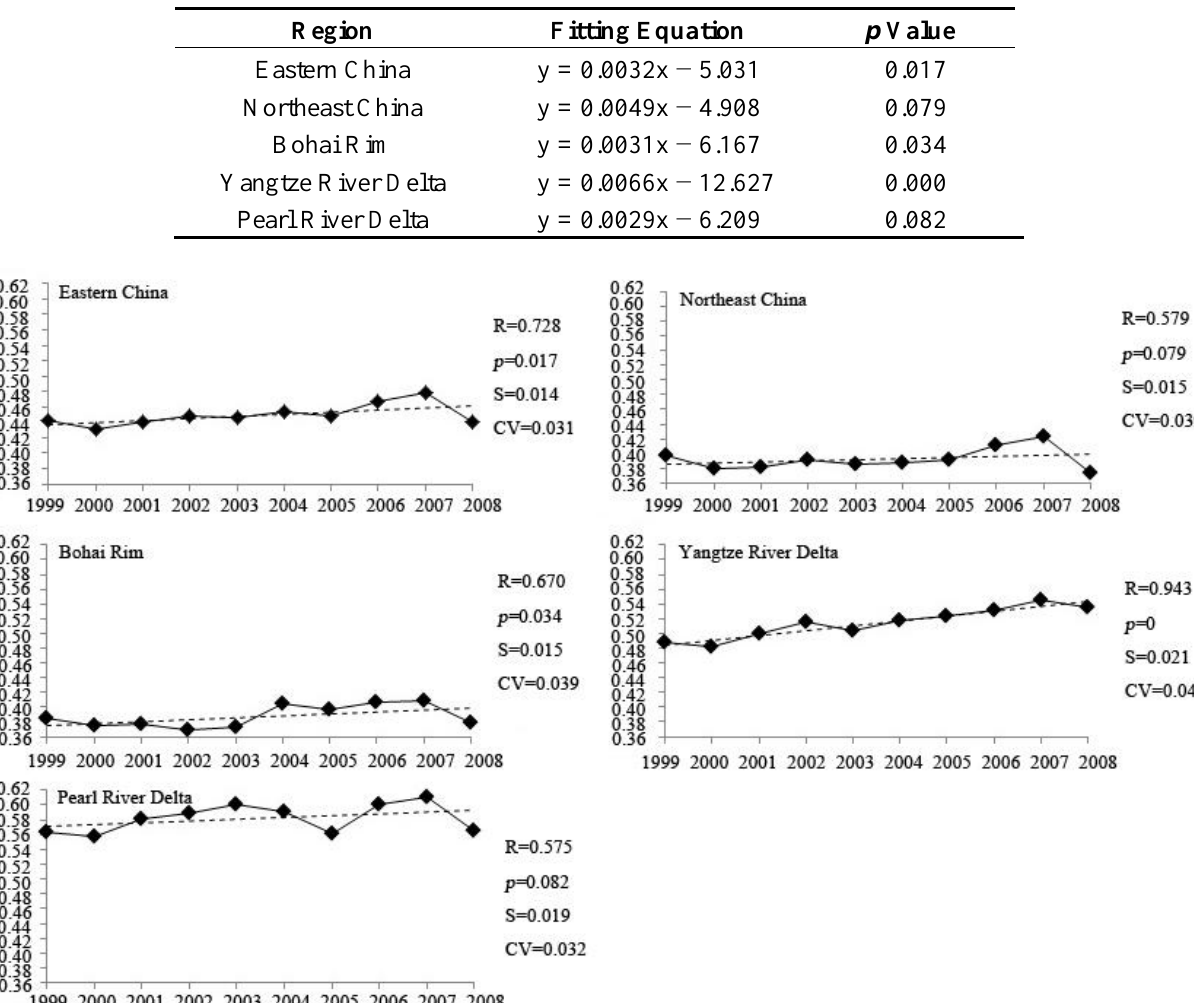
Table 2. Trends of annual NDVI changes in Eastern China during 1999–2008.